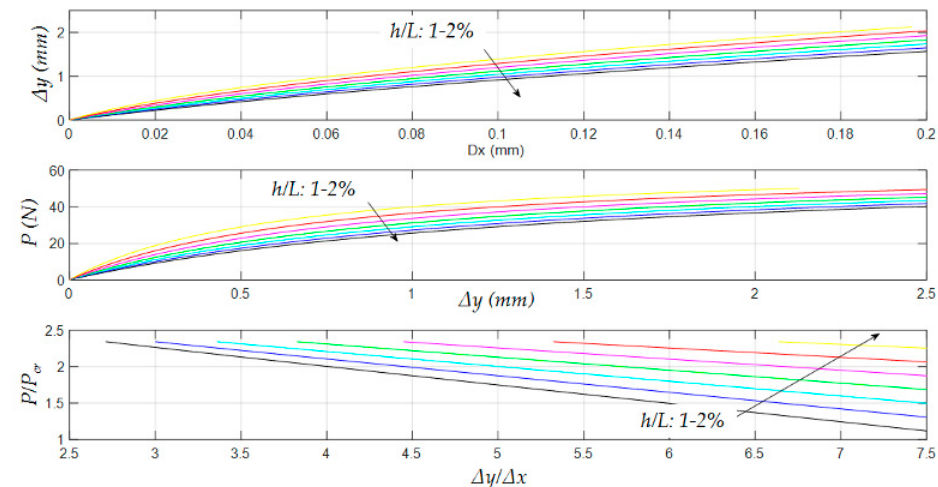
Figure 6. Transversal displacement ( ∆ y ), applied load ( P ) and load normalized with respect to critical buckling load ( P/P cr ) as a function of axial ( ∆ x ) and transversal ( ∆ y ) displacements, and their ratio ( ∆ y / ∆ x ), respectively. Curves parameterized vs the shape coefficient ( h / L ) in the range of